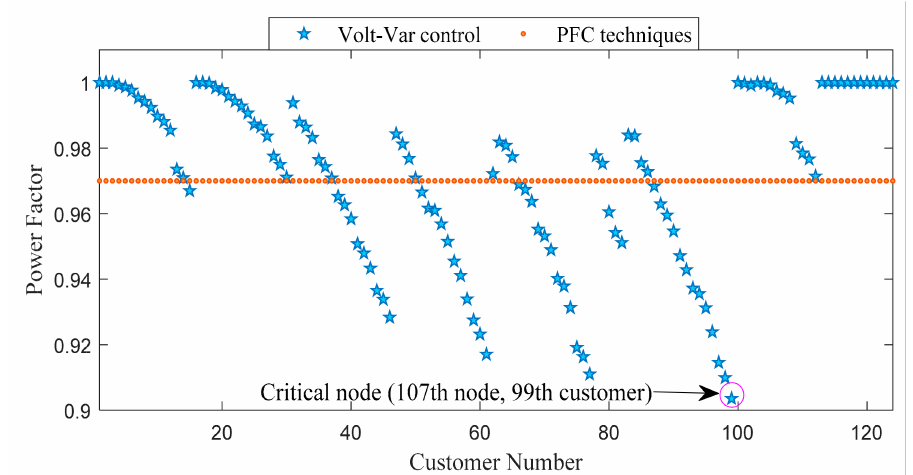
Figure 12. Variation of the power factor with the customer